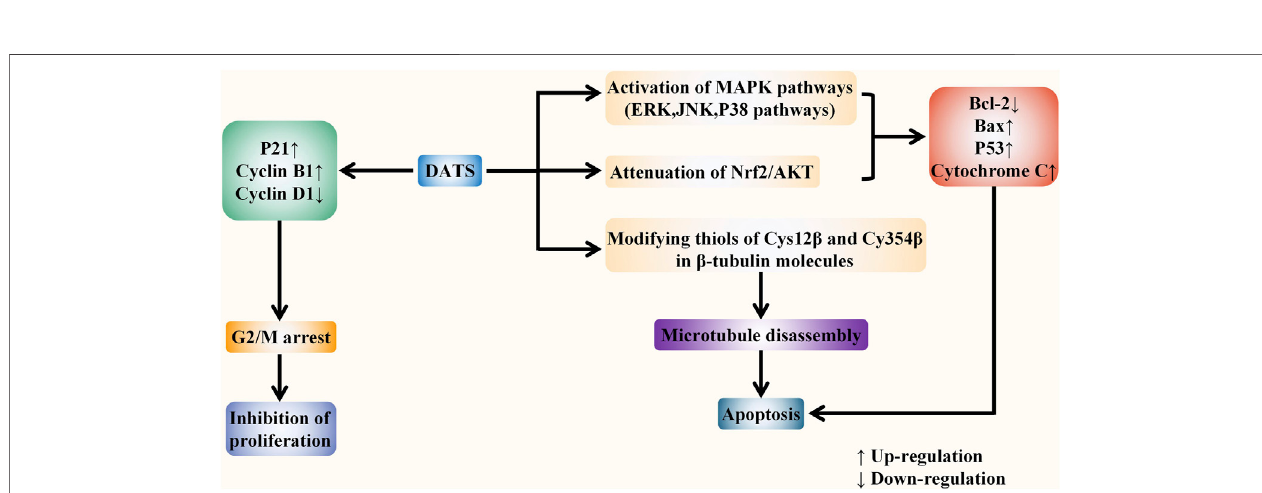
FIGURE 6 | DATS fi ghts against digestive system cancers in vitro . DATS exerts the anti-tumor role mainly in two ways: inhibiting proliferation and inducing apoptosis. DATS can inhibit cell proliferation by inducing G2/M phase arrest via regulating the levels of P21 and Cyclin. In addition, DATS can activate three MAPK pathways and attenuate Nrf2/Akt pathway to regulate apoptosis-related proteins. Moreover, it has also been shown to induce rapid microtubule disassembly by modifying thiols of Cys12 β and Cys354 β in β -tubulin molecules, thereby inducing apoptosis.